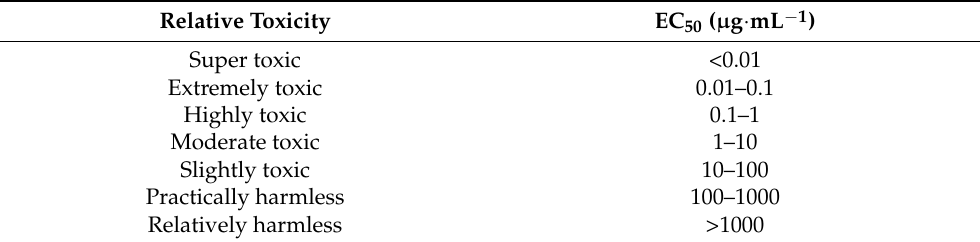
Table 3. Passino and Smith toxicologic